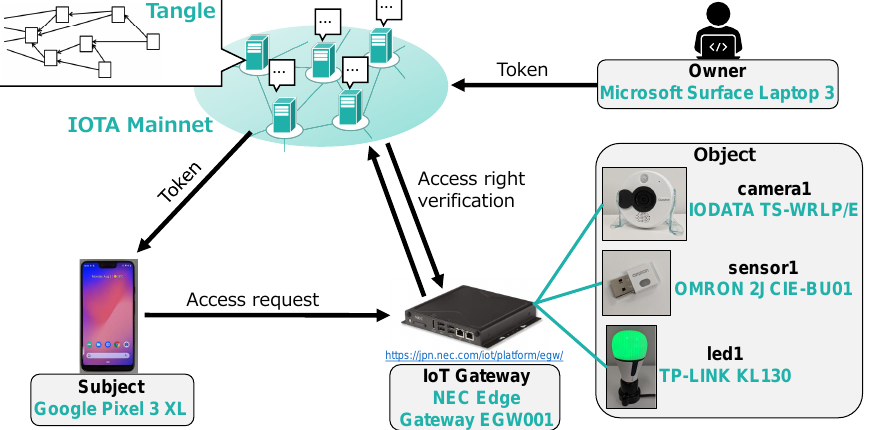
Figure 10. Configuration of the prototype